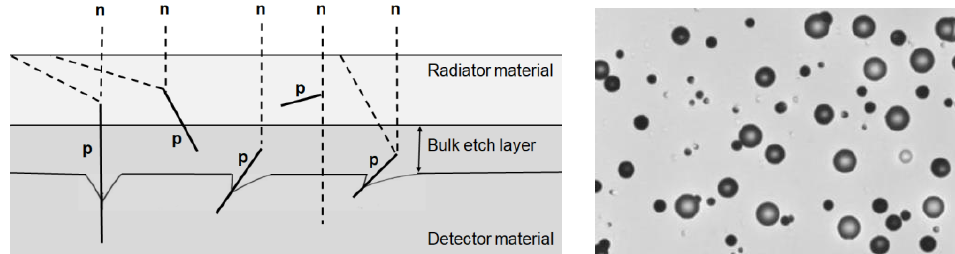
Figure 1. Cross-sectional view with radiator material irradiated by incident neutrons ( left ) and image of pits due to recul protons in a CR-39 track detector ( right ).